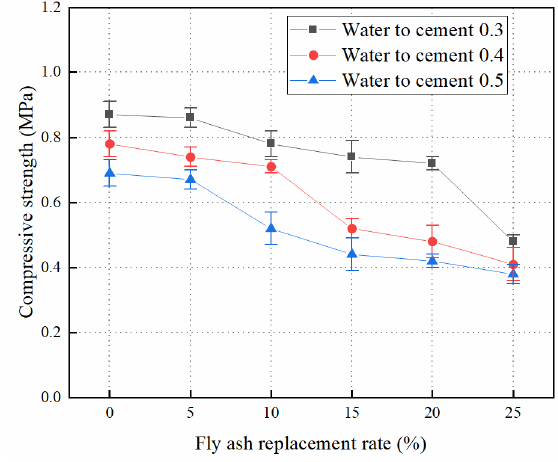
Figure 8. The 28d compressive strength of foam concrete with different matching